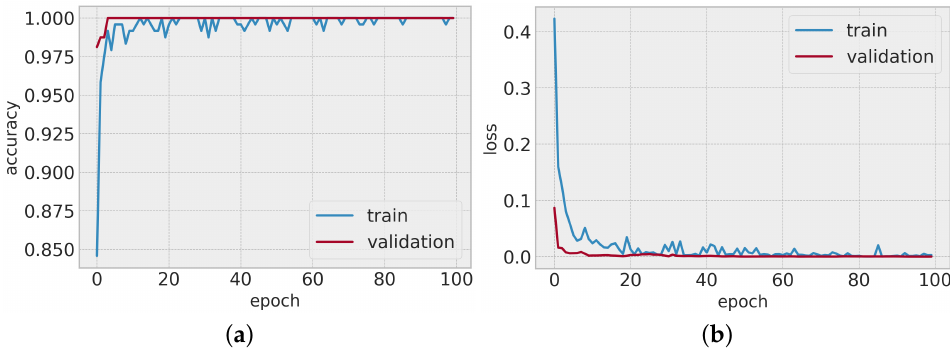
Figure 4. ( a ) Accuracy and ( b ) loss curves for COVID-19 diagnosis